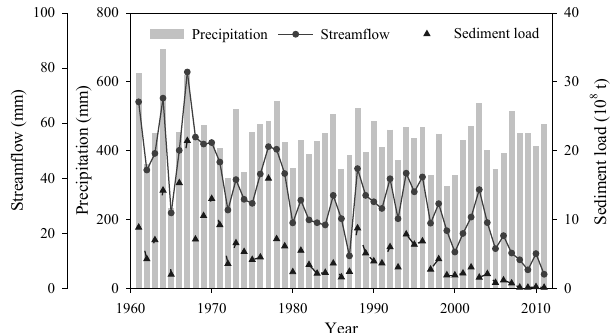
Figure 3. Annual precipitation, streamflow, and sediment load for the whole CSHC region during